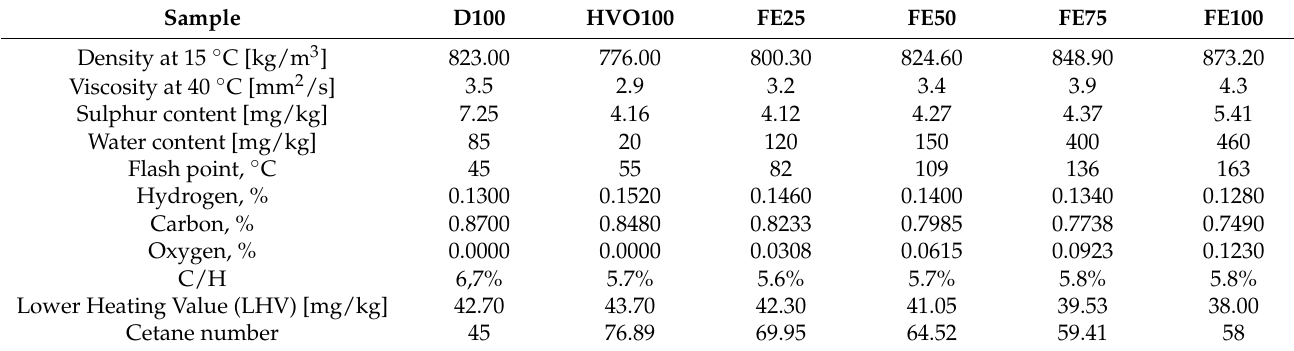
Table 1. Physicochemical properties of the analyzed